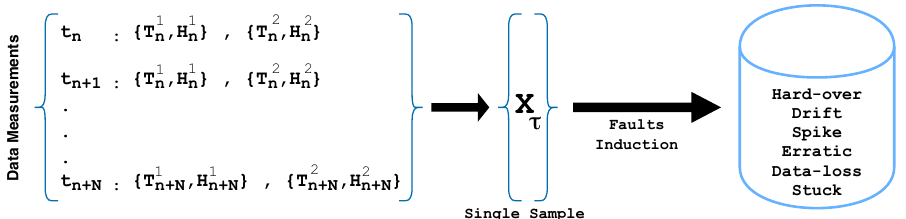
Figure 7. Illustration of the data